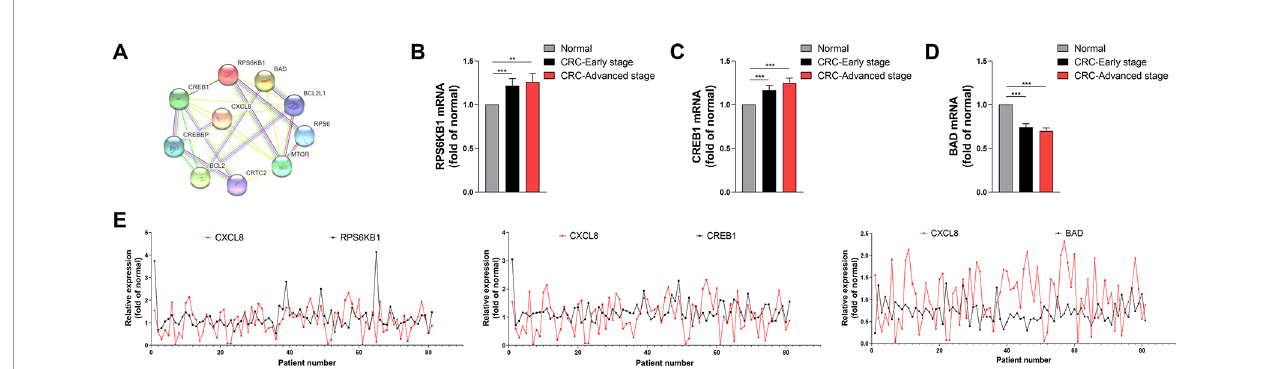
FIGURE 4 | Expression of RPS6KB1 and CREB1 is upregulated and positively correlates with CXCL8 expression, while Bcl2 associated agonist of cell death ( BAD) is downregulated and negatively correlates with CXCL8 expression in colorectal cancer (CRC). (A) Protein-protein interaction (PPI) network. (B) Expression of RPS6KB1 mRNA expression in normal (N = 81), CRC-early stage (N = 44), and CRC-advanced stage (N = 37) groups. (C) Expression of CREB1 mRNA expression in normal (N = 81), CRC-early stage (N = 44) and CRC-advanced stage (N = 37) groups. (D) Expression of BAD mRNA expression in Normal (N = 81), CRC-early stage (N = 44), and CRC-advanced stage (N = 37) groups. (E) Expression of RPS6KB1 , CREB1 , BAD mRNAs compared with that of CXCL8 mRNA in CRC (N = 81). Statistical signi fi cance was performed by the Mann-Whitney U test. ** p < 0.01, *** p <